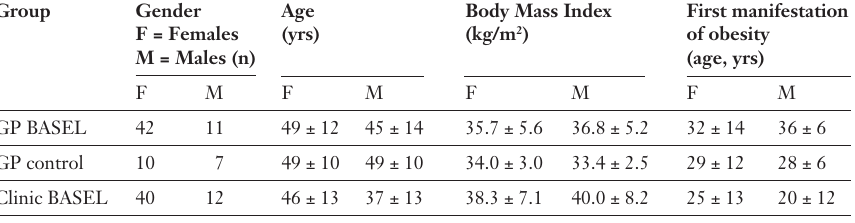
Session Treatment No. Contents of